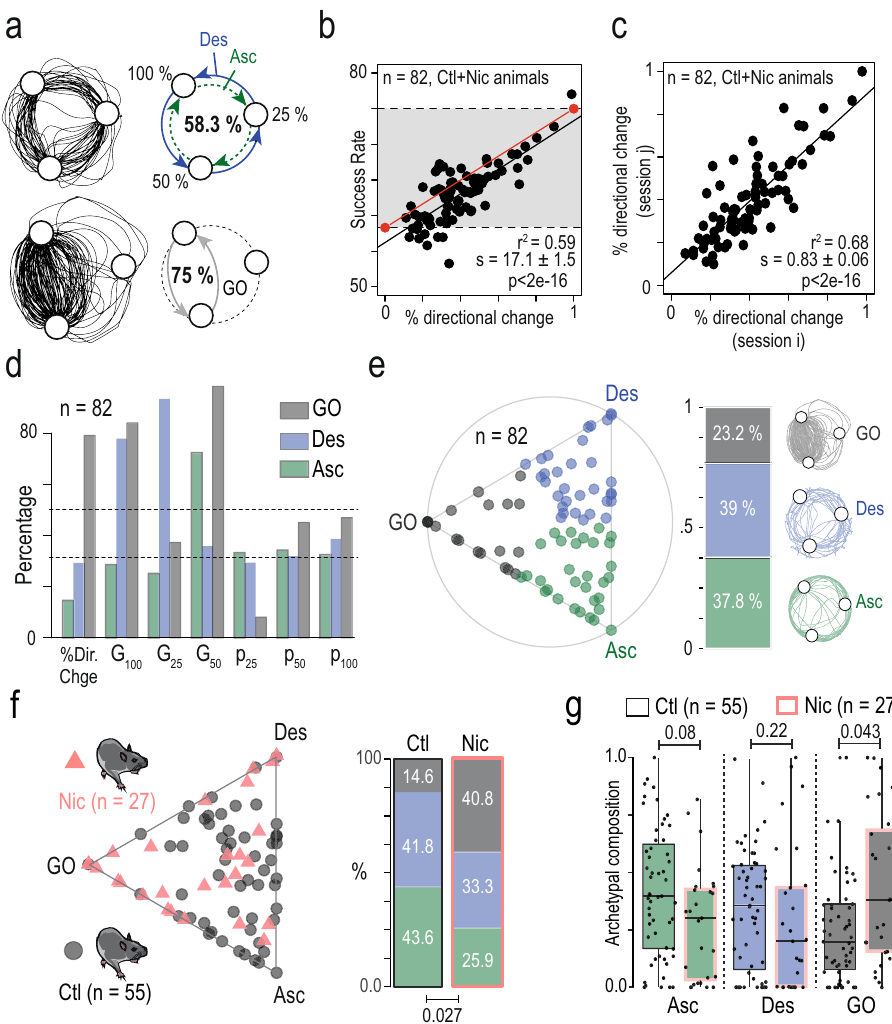
Fig. 3 Mice exhibited inter-individual differences in choice strategies which were differentially affected by chronic nicotine exposure. a Left: sample trajectories in the probabilistic setting (PS), corresponding to different choice strategies, a circular strategy (top) and a gain-optimizing strategy (bottom). Right: a mouse using a purely circular strategy (top, descending Des or ascending Asc) in the PS will tend to a 58.3% success rate, whereas a mouse that always avoids P 25 and alternates between P 100 and P 50 (bottom) will reach 75% of success rate. b Correlation between the success rate and the percentage of directional changes (linear regression, adjusted r 2 , the slope estimate s and its p value). Mice displayed a strong inter-individual variability in their choice strategy but, overall, the higher the percentage of directional change, the higher the success rate (regression line in black). The red line indicates the linear correlation passing through two theoretical points: {0% directional changes; 58.3% success rate} and {100% directional changes; 75% success rate}. c Correlation between the percentage of directional changes for two consecutive sessions (linear regression, adjusted r 2 , the slope estimate s and its p value). This measure showed a strong stability between consecutive sessions, indicating that the decision strategy was conserved across time for a given individual. d , e Archetypal analysis of the choice strategies based on 7-dimensional data space: (i) the % of directional changes, (ii) the gambles G 100 , G 25 and G 50 , and (iii) the distribution of choices between P 25 , P 50 , and P 100 . Analysis was performed on n = 82 mice (pooled control and nicotine mice). d Plot of the three archetypal solutions, gain-maximizers (GO), descending (Des) and ascending (Asc), and their 7 basic variables used in this analysis. e Left: visualization of the α coef fi cients using a ternary plot. Each point represents the projection of an individual onto the plane de fi ned by a triangle where the three apices represent the three archetypes (GO, Des, and Asc). Points are color-coded according to their proximity to the archetypes. Right: proportions of each archetype on the entire population: 37.8% Asc (green), 39% Des (blue), and 23.2% GO (gray). f Left: nicotine (Nic, pink triangles) and control (Ctl, gray dots) mice displayed on the same ternary plot. Nic mice displayed a visual shift of their behavior towards the GO extrema of the archetype. Right: this shift was re fl ected by a difference in the proportion of each phenotype between nicotine and control groups ( χ 2 test, p = 0.027), with a higher proportion of GO mice in the nicotine group. g Archetypal composition for each archetype (1 = closer to the apex) in control and nicotine mice (two-sided Wilcoxon test, p = 0.08, p = 0.22, and p = 0.04, with Holm correction). For ( g ), data are shown as mean ± sem. Boxplot shown median, quartiles, and extreme values. See also source making parameters and session number after the fi rst 5 sessions Directional changes showed a strong positive correlation from (Supplementary Fig. 4b). Furthermore, to test whether the one session to the next (Fig. 3c), suggesting a strong consistency variabilities in behavior were robust for each individual from in individual behaviors. This observation was generalized by trial to trial, we compared the percentage of directional changes demonstrating that intra-individual variations are lower than the for two consecutive sessions for each animal of the control group. inter-individual variations (Supplementary Fig. 4c).